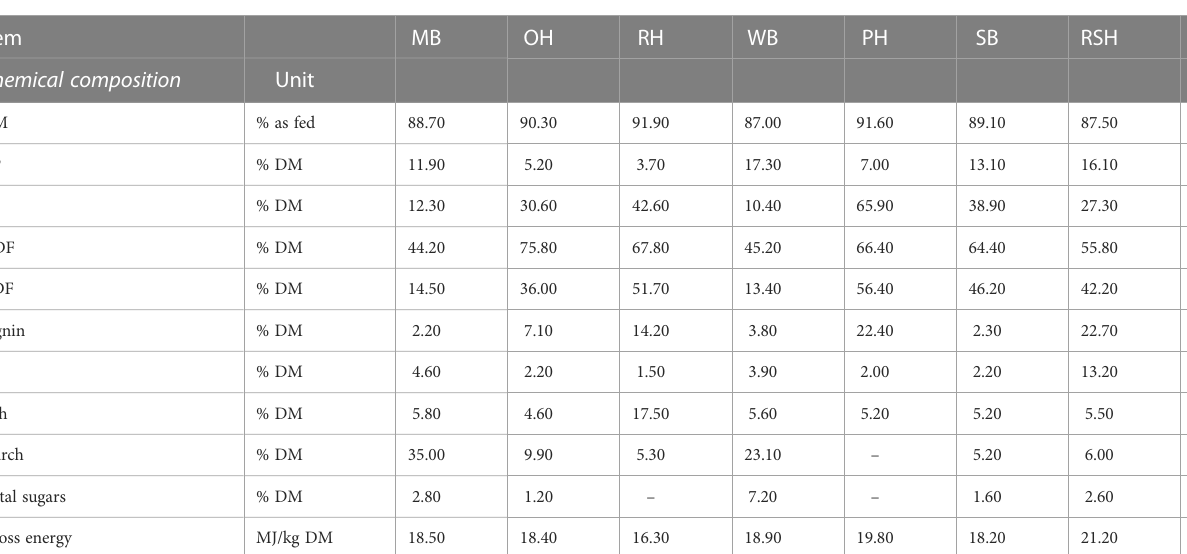
TABLE 1 Composition of DF commonly used in